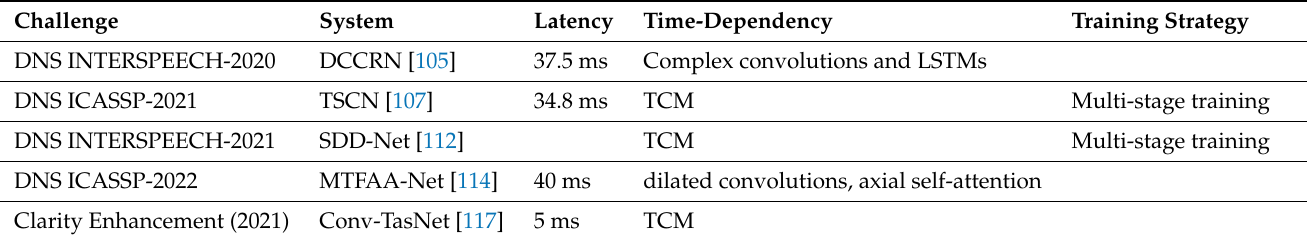
Table 4. Comparison of winning systems in speech enhancement